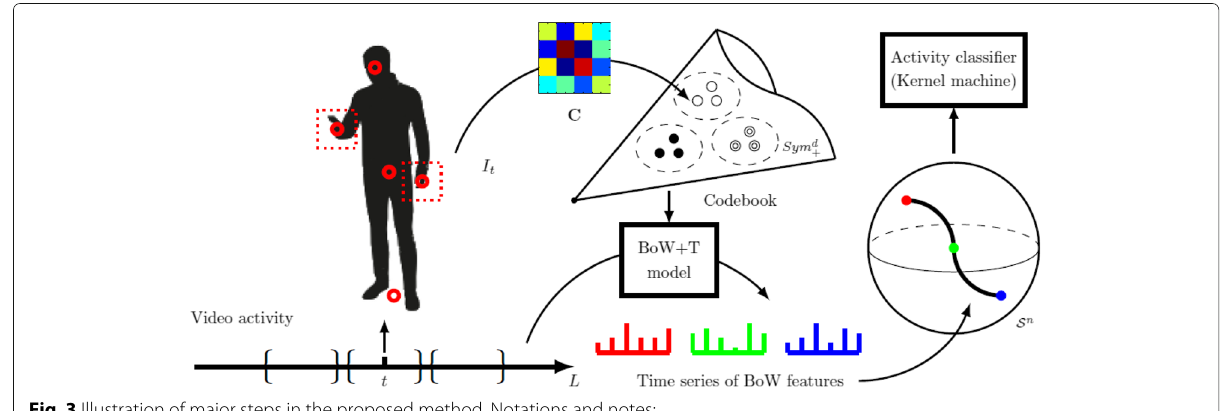
Fig. 3 Illustration of major steps in the proposed method. Notations and notes: • I t is the t -th frame of an input video, and L is the total number of frames • “ ◦ ” are key points (head, hands, waist center, midpoint of feet), and the areas with dotted edges are local patches centered at hands • C is the frame-based covariance feature (as a point on the manifold of SPD matrices Sym d + ) extracted from local patches and key points in I • The codebook for BoW+T model is generated by clustering covariance matrices on Sym d + • The video is encoded by the BoW+T model as a time series of manifold points on a unit n -sphere S n and then classified by a kernel machine based on geodesic distance on that